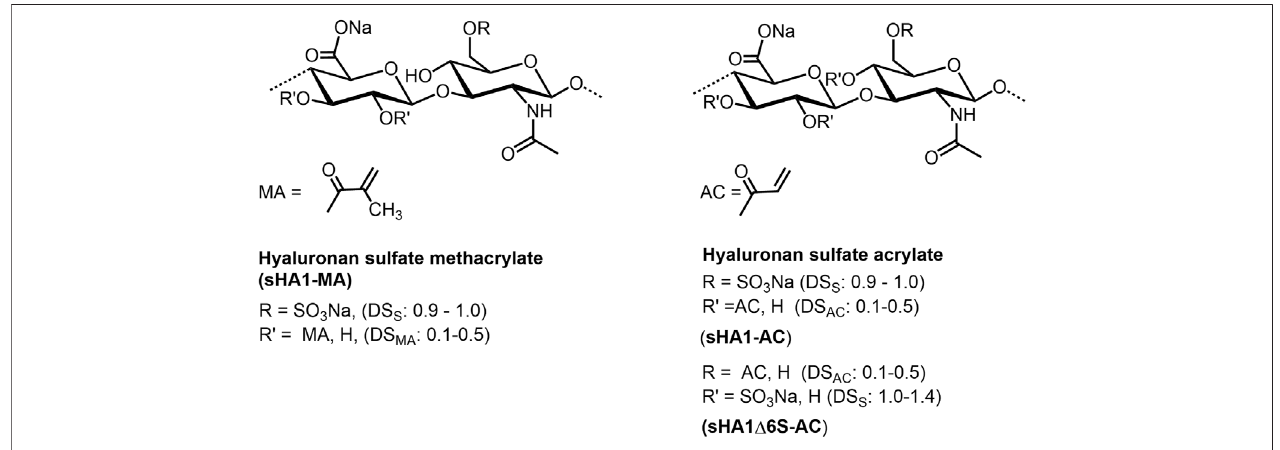
FIGURE 7 | Sulfated methacrylates, and sulfated acrylates of HA.